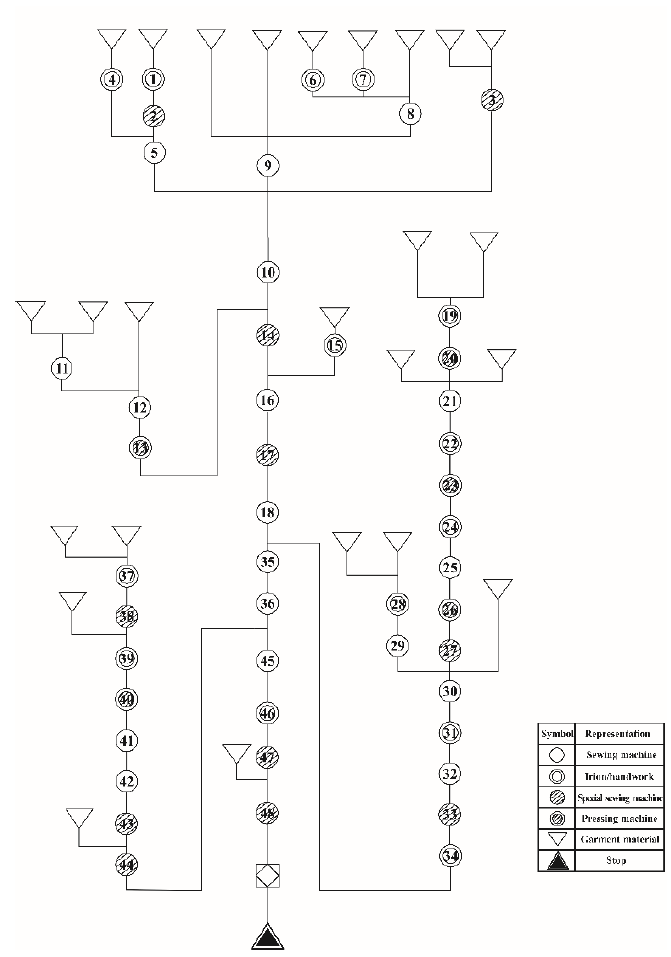
Figure 7. Process flow chart of the men’s shirt. Table 1. Sewing processes of the men’s shirt.